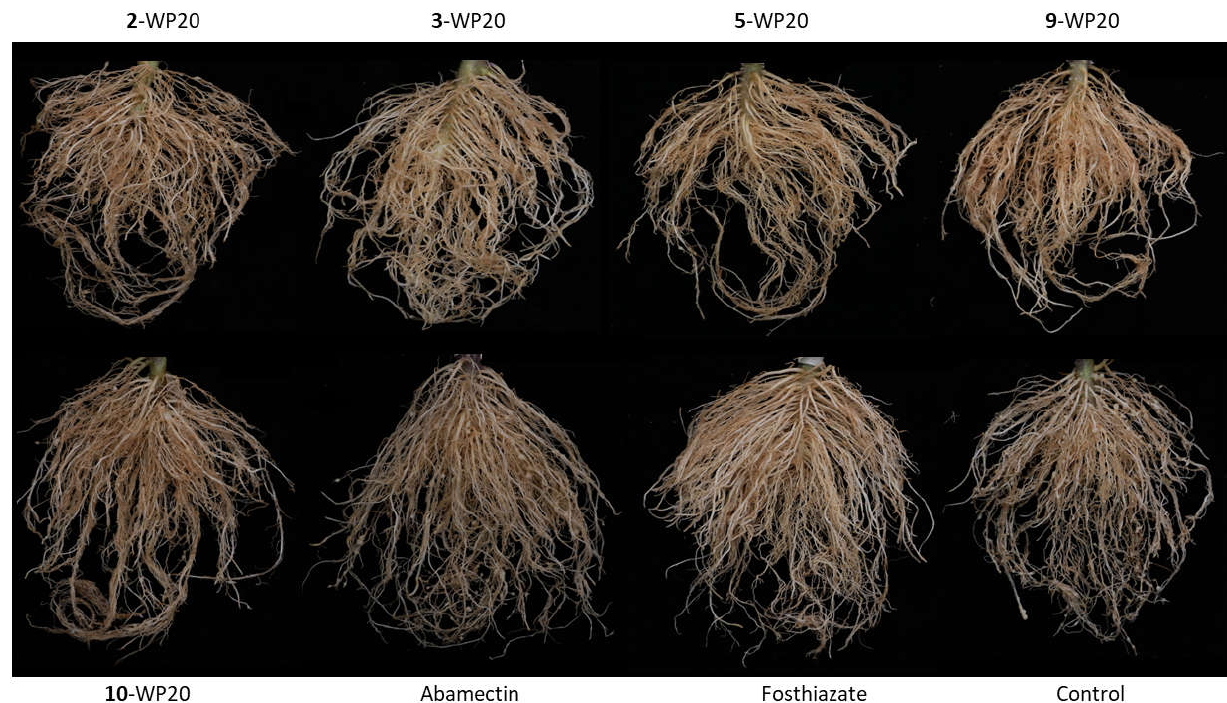
Figure 6. Effect of wettable powder formulations of 2,5-dihydroxybenzaldehyde (2-WP20), m-cresol (3-WP20), toluquinol (5-WP20), grammicin (9-WP20), and 2,4-dihydroxybenzaldehyde (10-WP20) on gall formation in tomato roots infested with Meloidogyne incognita . Fosthiazate (4000-fold dilution) and abamectin (5000-fold dilution) were used as positive controls.